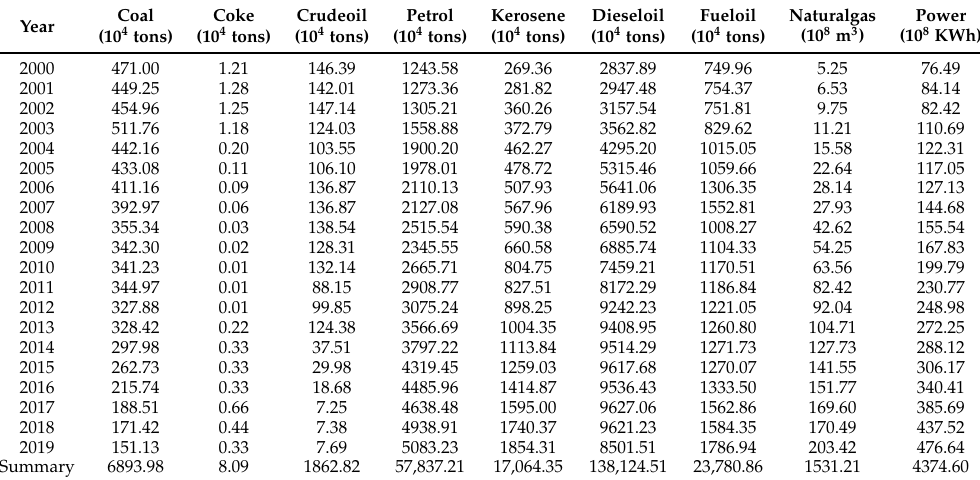
Table 2. Calculation of carbon dioxide released by each kind of energy